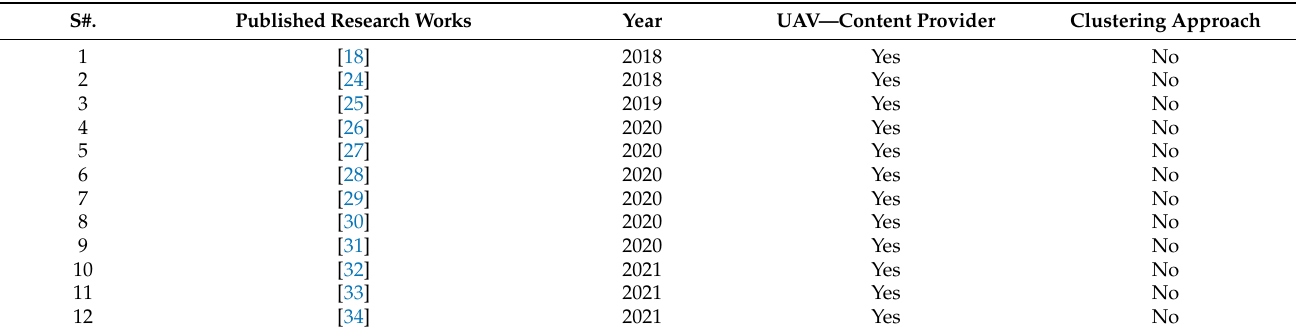
Table 1. An Overview of Relevant and Recent